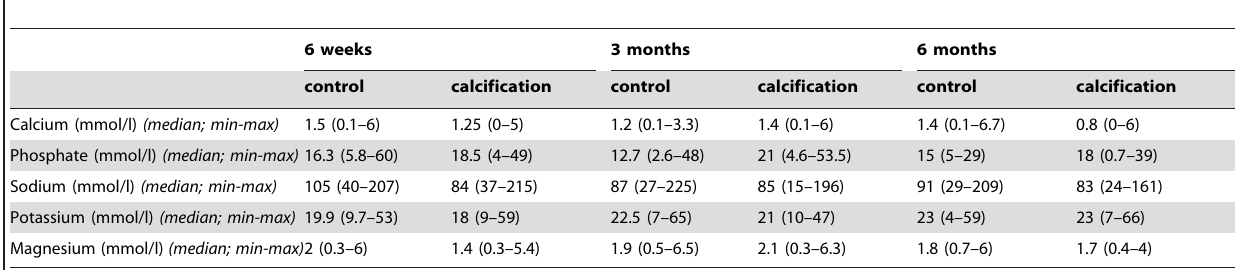
Table 3. Urinary mineral ions in patients and controls at biopsy time points.